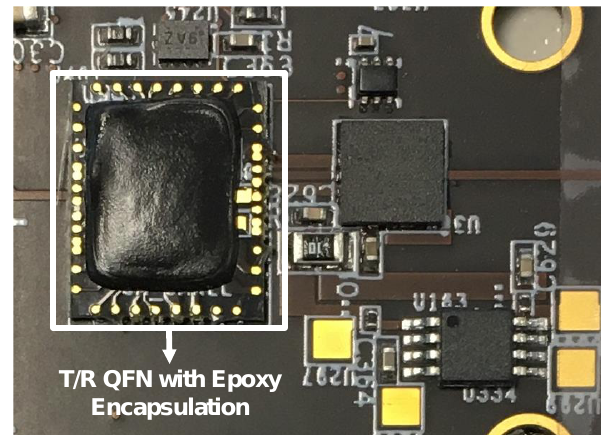
Figure 14. Top view of a CMOS T/R QFN